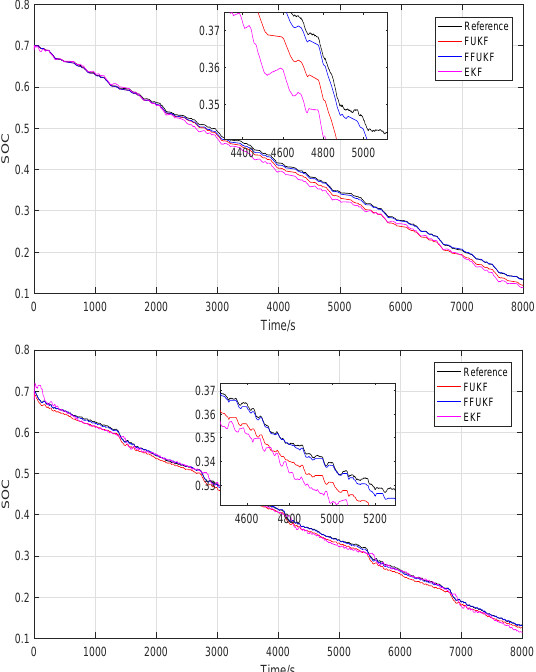
Figure 12. The SOC estimation curves under BJDST and FUDS at 0 ◦